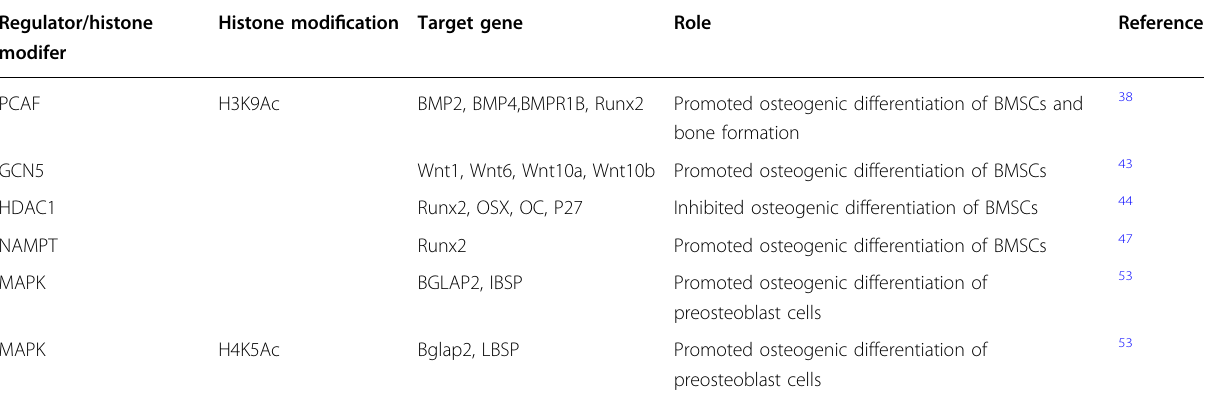
Table 1 Histone acetylation centric-regulation in osteogenic genes expression.